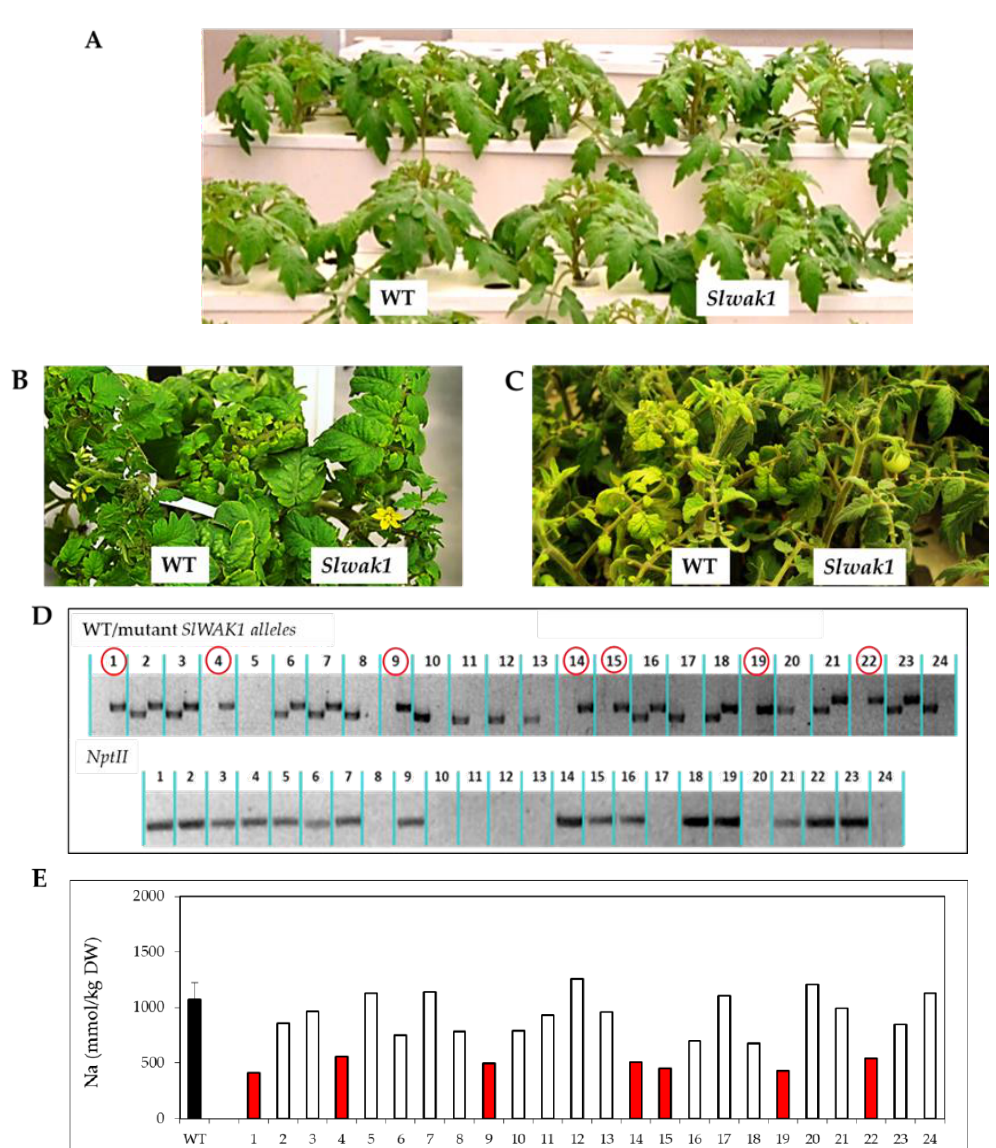
Figure 2. Phenotypic, physiological and genetic characterization of Slwak1 mutant. At the phenotypic level, no differences between WT and the segregating progeny of Slwak1 mutant plants are observed under control conditions ( A ), while the mutant plants showed lower degree of chlorosis in their leaves after 10 days ( B ) and 20 days ( C ) of 200 mM NaCl treatment. ( D ) PCR genotyping for presence of mutant ( Slwak1 ) and WT SlWAK1 alleles as well as NptII gene in a T 2 Slwak1 population. Individuals marked with red circles exhibited the mutant phenotype (with the mutant allele in homozygosis) and all of them showed presence of NptII gene. ( E ) Na + accumulation in the first developed leaves of WT and T 2 Slwak1 population. The phenotype of the mutant plants (lower degree of leaf chlorosis under salinity) correlated with the genotype of the segregating progeny, as well as with lower Na + accumulation in leaves of these plants under salt stress.